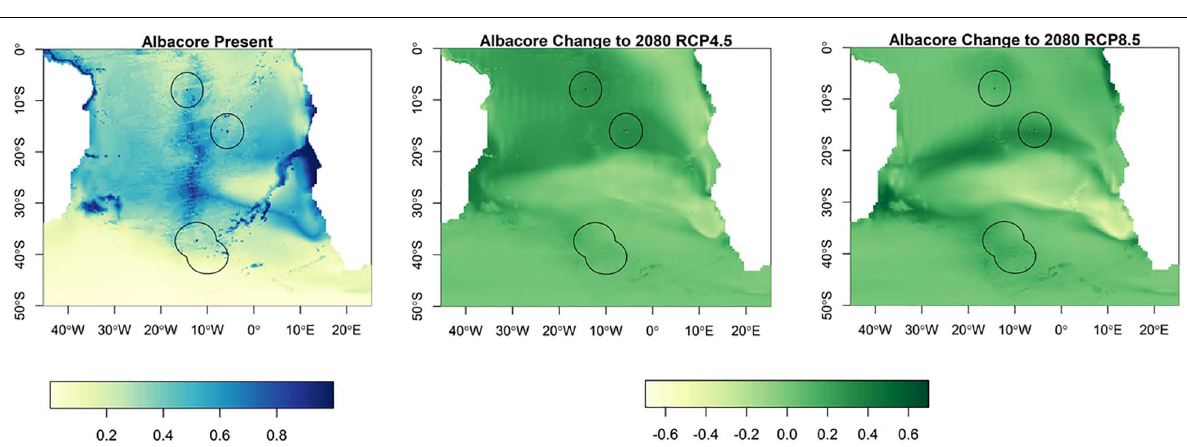
FIGURE 3 | The habitat suitability for albacore tuna from Maxent in the South Atlantic for the present day and the change to 2080 under RCP4.5 and RCP8.5. The EEZs are shown in the black outline. The yellow areas are the most suitable, and the dark blue the least